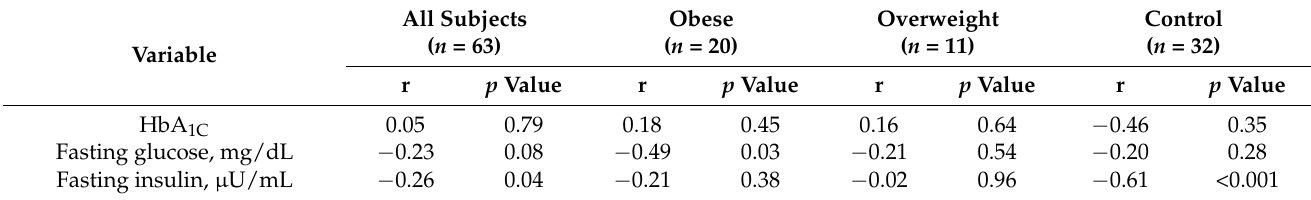
Table 3. Correlation between serum sclerostin level and metabolic parameters.